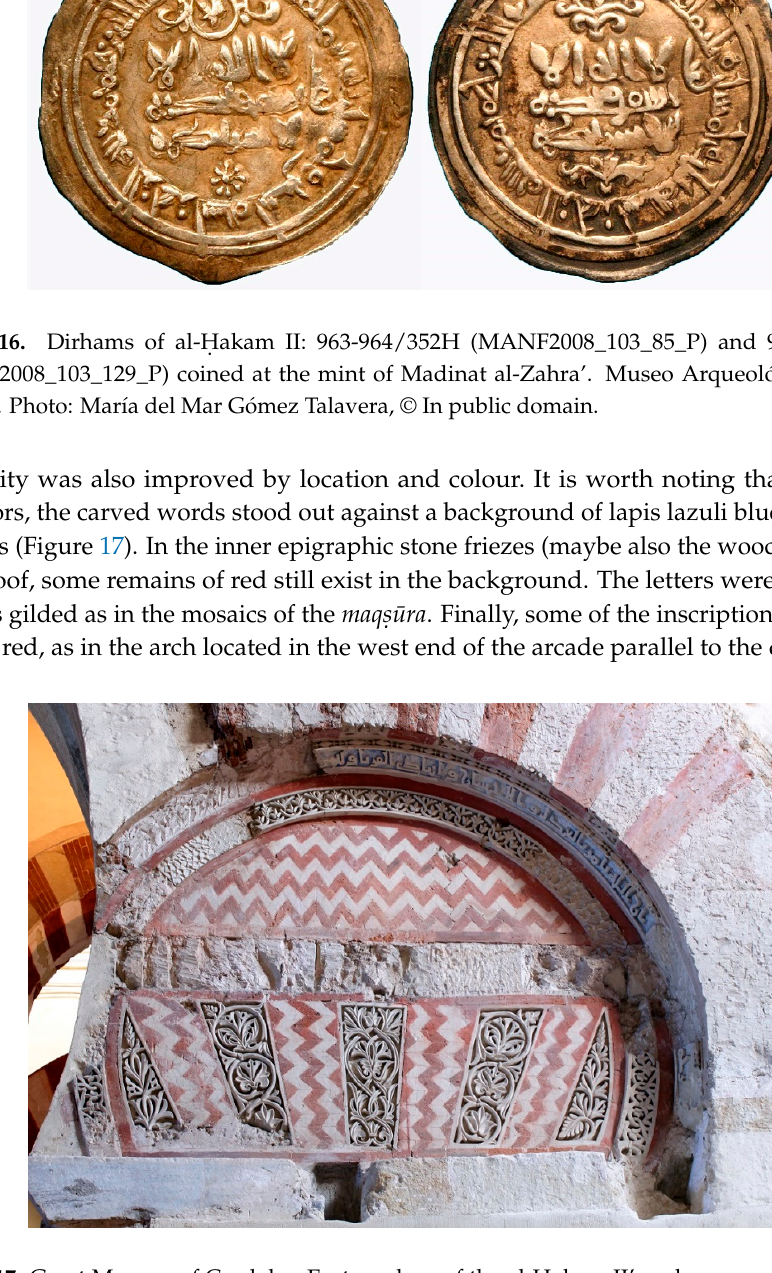
Figure 17. Great Mosque of Cordoba. Eastern door of the al- Ḥ akam II’s enlargement with traces of polychromy. © Photo took by author.